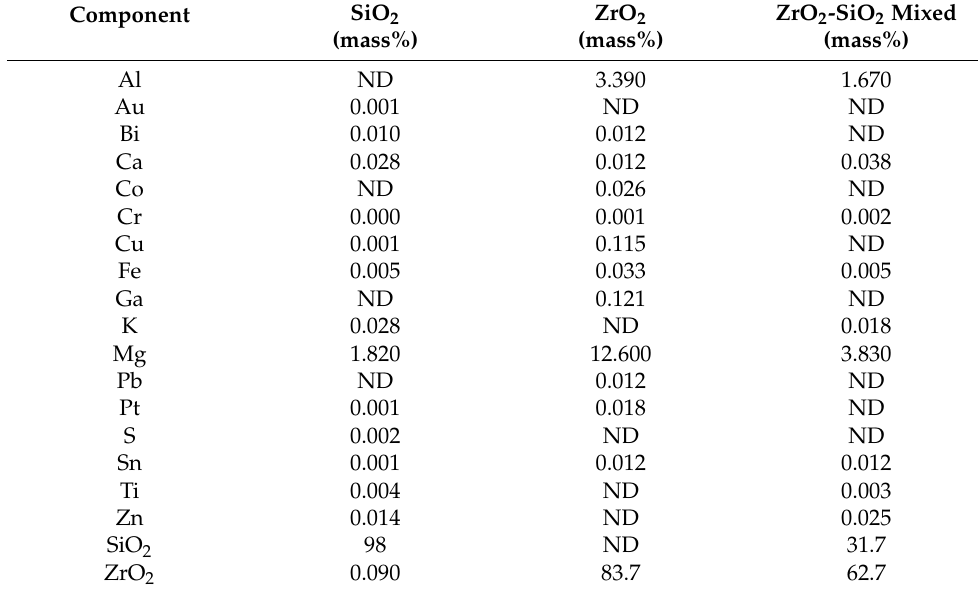
Table 2. XRF Filler SiO 2 , ZrO 2, and ZrO 2 -SiO 2